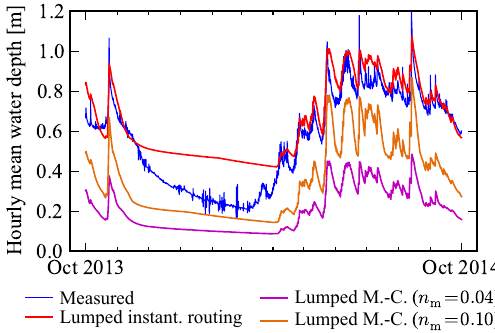
Figure 8. Water depth as simulated by StreamFlow in hydrologi- cal year 2014 using various channel water routing techniques. The measured water depth is indicated in blue and shown here only as an indication (see text). Regarding the curves associated with the Muskingum–Cunge routing technique, only those obtained us- ing lumped stream reaches are shown (orange and violet curves). Those corresponding to discretized stream reaches almost overlap with their lumped counterparts, with the difference between each pair of curves amounting to a RMSE of 0 . 5mm for n m = 0 . 04 and 3 . 9mm for n m = 0 . 10 over the entire period